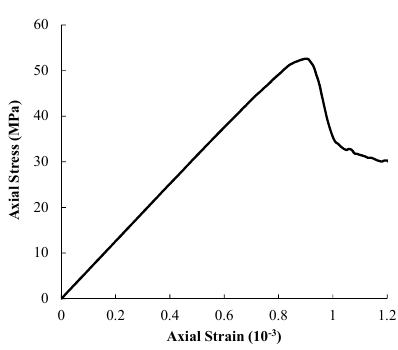
Figure 4. The stress–strain curve of the uniaxial compressive test. Table 1. Parameters used in the numerical simulation [20,33].